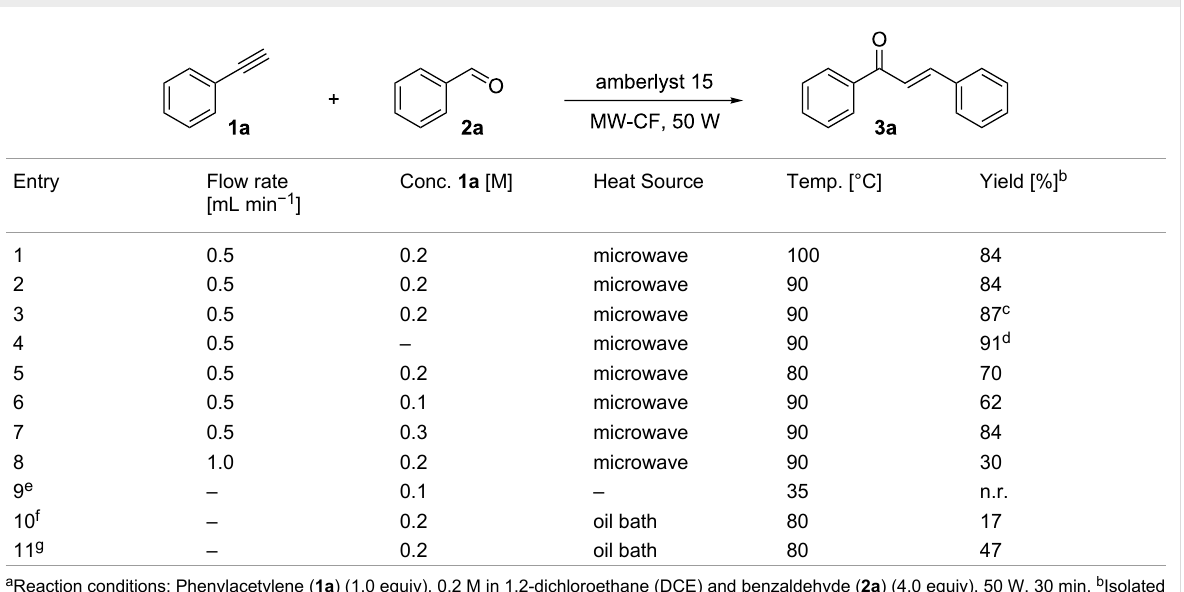
Table 1: Optimization of hydration–condensation reactions. a